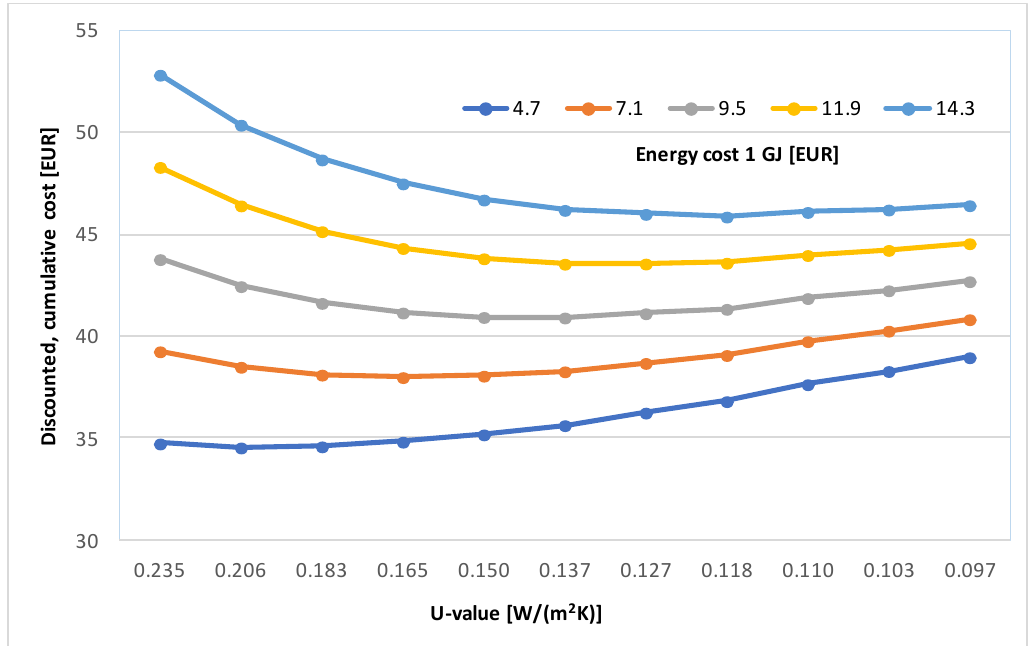
Figure 2. The discounted, cumulative cost (K Rd ) per m 2 for renovated external wall depending on U-value and the energy cost.